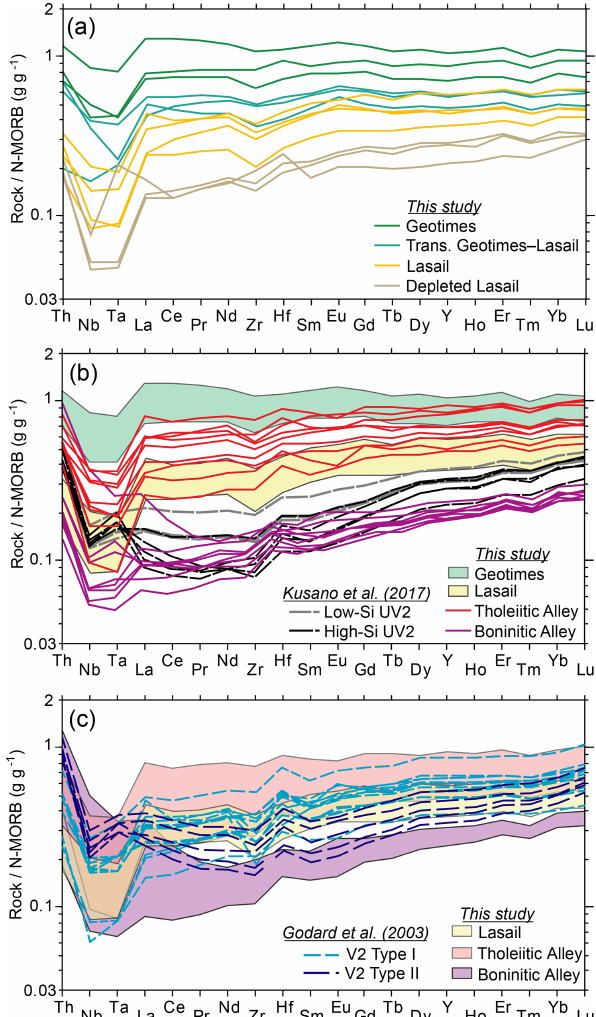
Figure 4. Incompatible-element patterns normalised to N-MORB (Gale et al., 2013) for a subset of our samples. (a) Geotimes, tran- sitional Geotimes–Lasail, Lasail, and depleted-Lasail patterns (this study). (b) Tholeiitic Alley and Boninitic Alley patterns in compar- ison to the Geotimes and Lasail ranges (this study) and low- and high-silica boninite glass compositions from (Kusano et al., 2017). (c) Lasail, Tholeiitic Alley, and Boninitic Alley compositions in comparison to V2 type I and II groups of Godard et al.